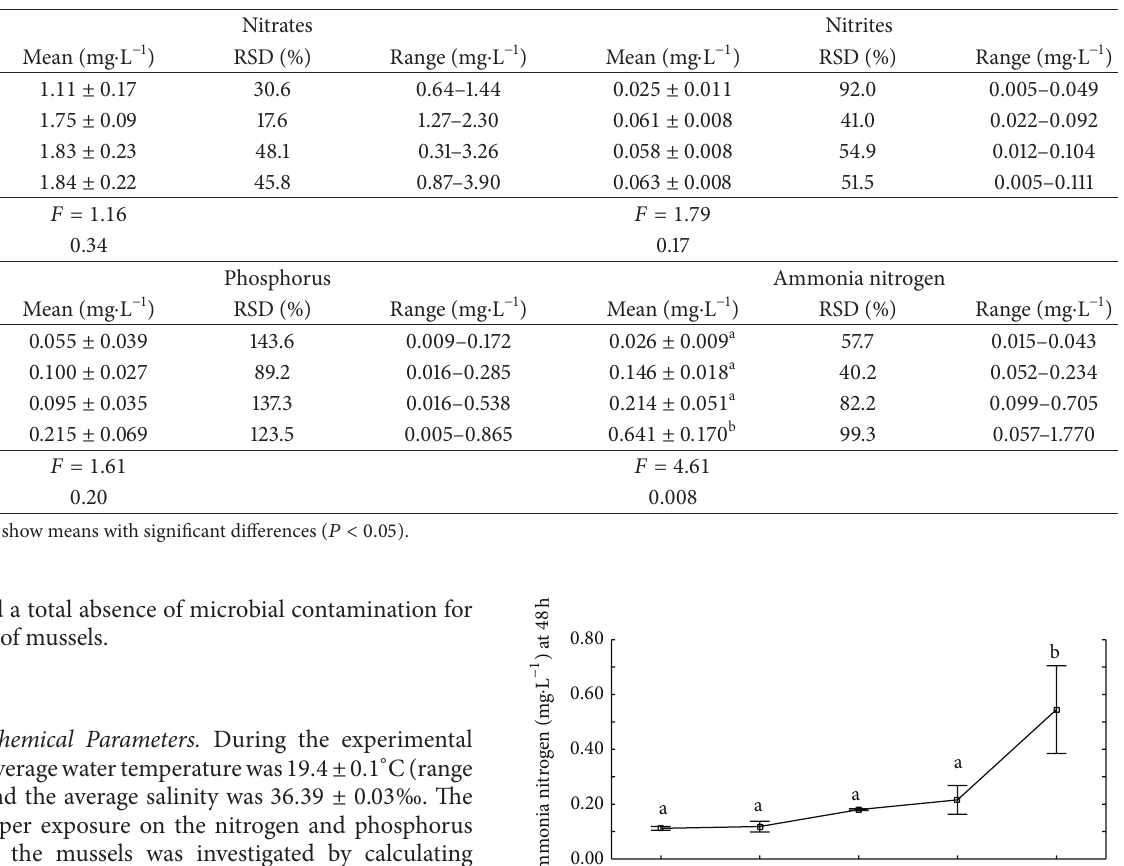
Table 1: Comparison of nutrients levels in seawater at different periods.